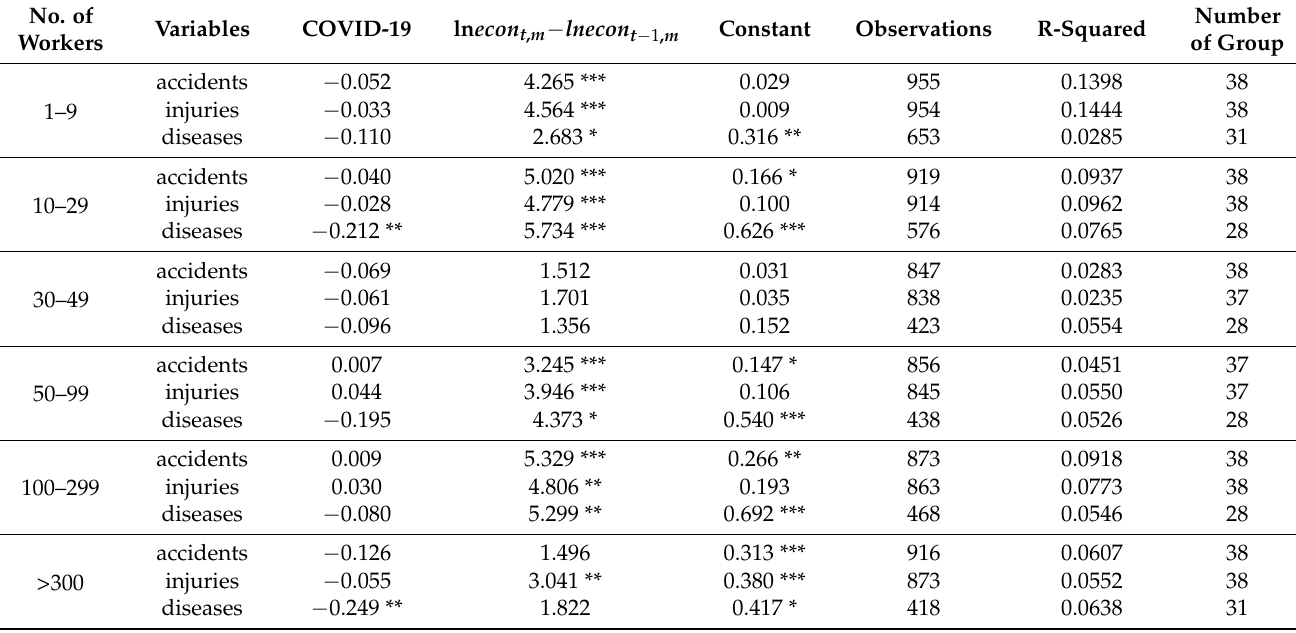
Table 7. Estimation results of fixed effects models by firm